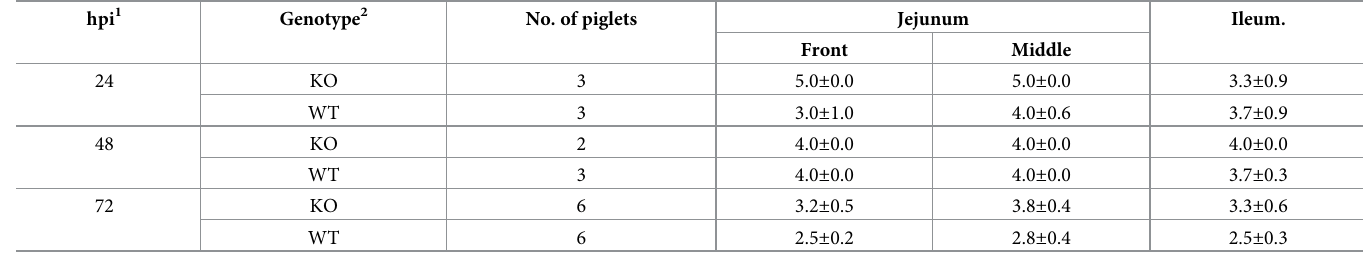
Table 8. Intensity of PEDV infection of epithelial cells of villi in CMAH KO piglets’ intestines revealed by immunofluorescence and histopathological (I/H)